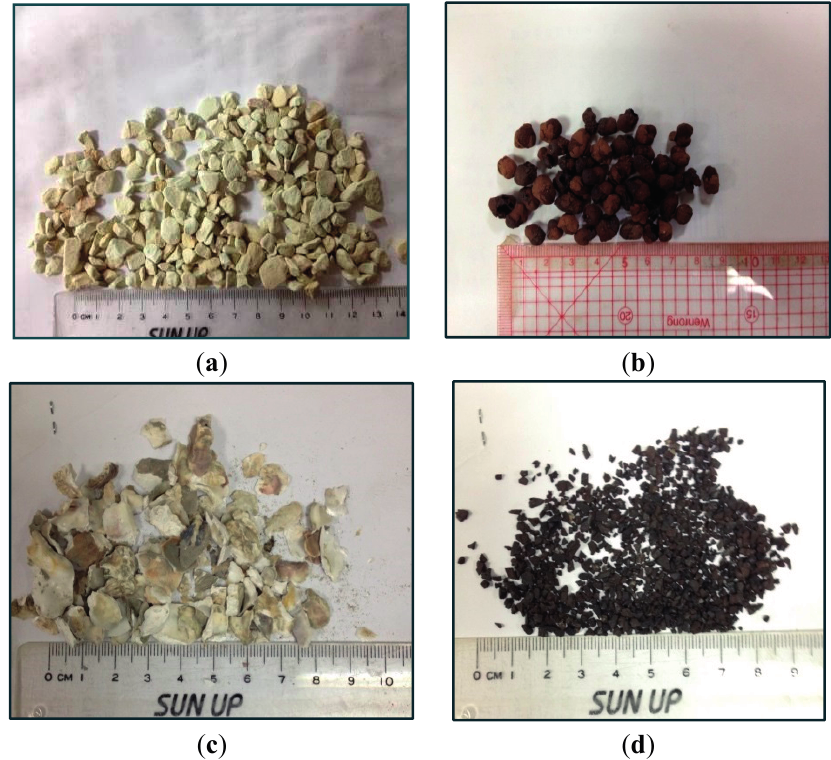
Figure 3. PL materials. ( a ) zeolite; ( b ) expanded clay aggregate; ( c ) oyster shells; ( d ) granular activated